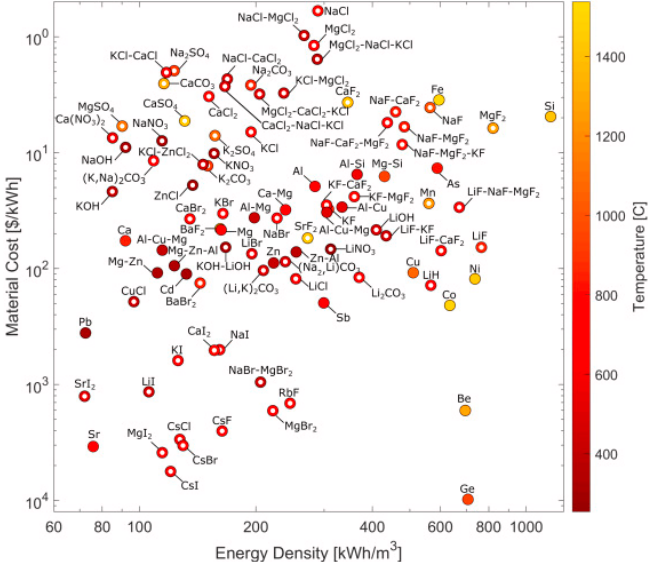
Figure 3. Energy density, cost and temperature of demonstrated phase-change materials for latent heat storage in CSP plants. Reprinted with permission [105]; 2020, Elsevier.